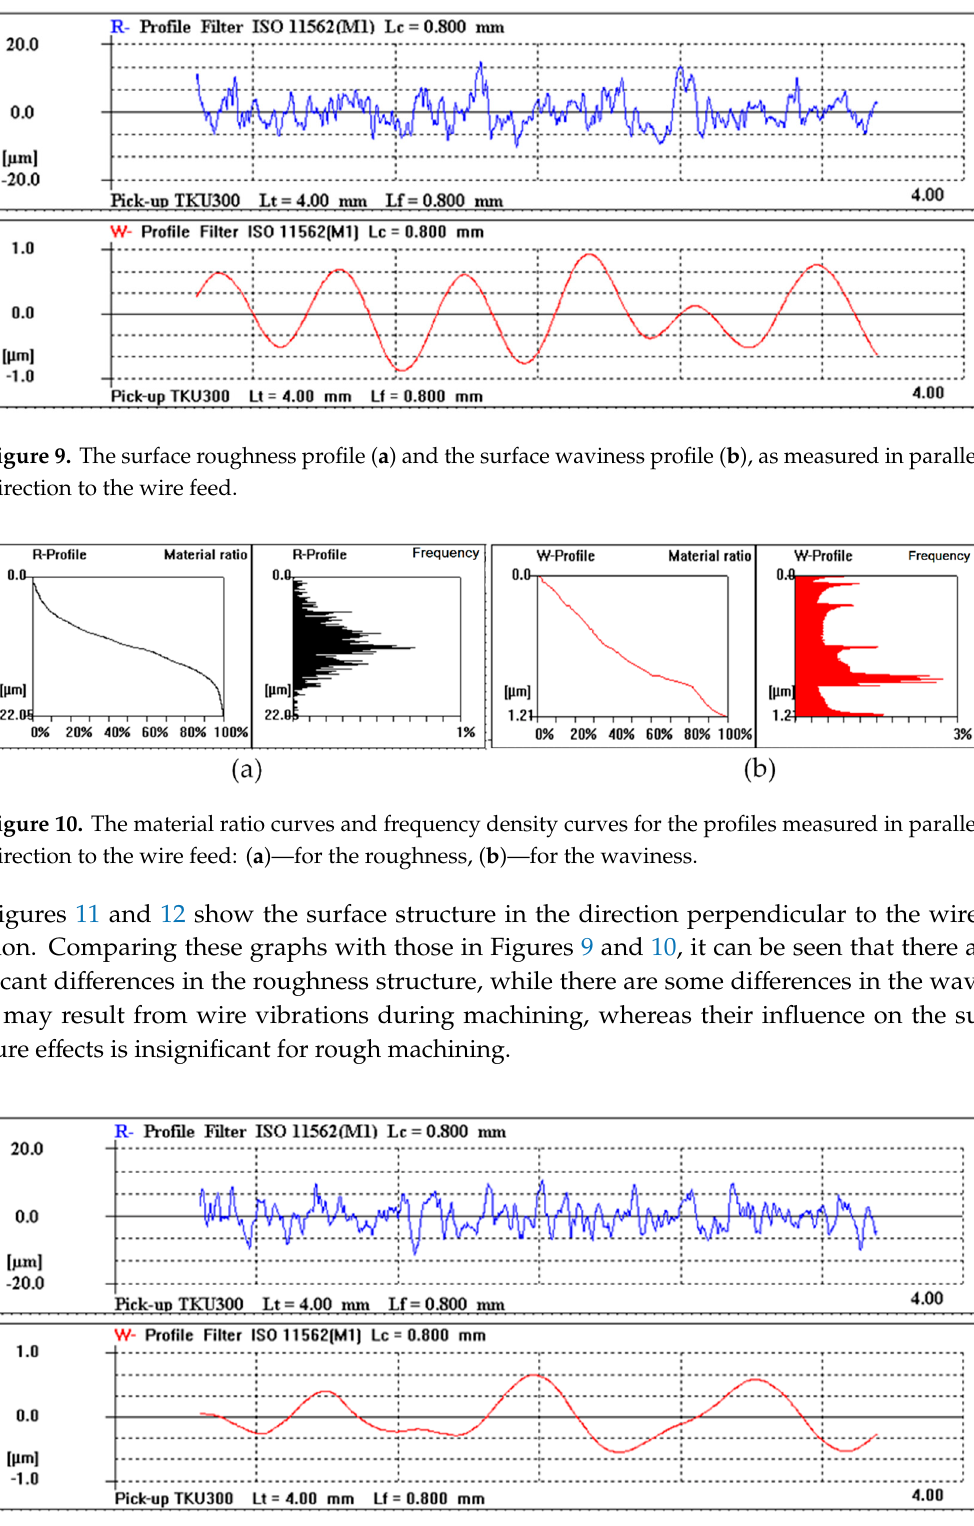
Figure 11. The surface roughness profile ( a ) and the surface waviness profile ( b ), as measured in perpendicular direction to the wire feed.